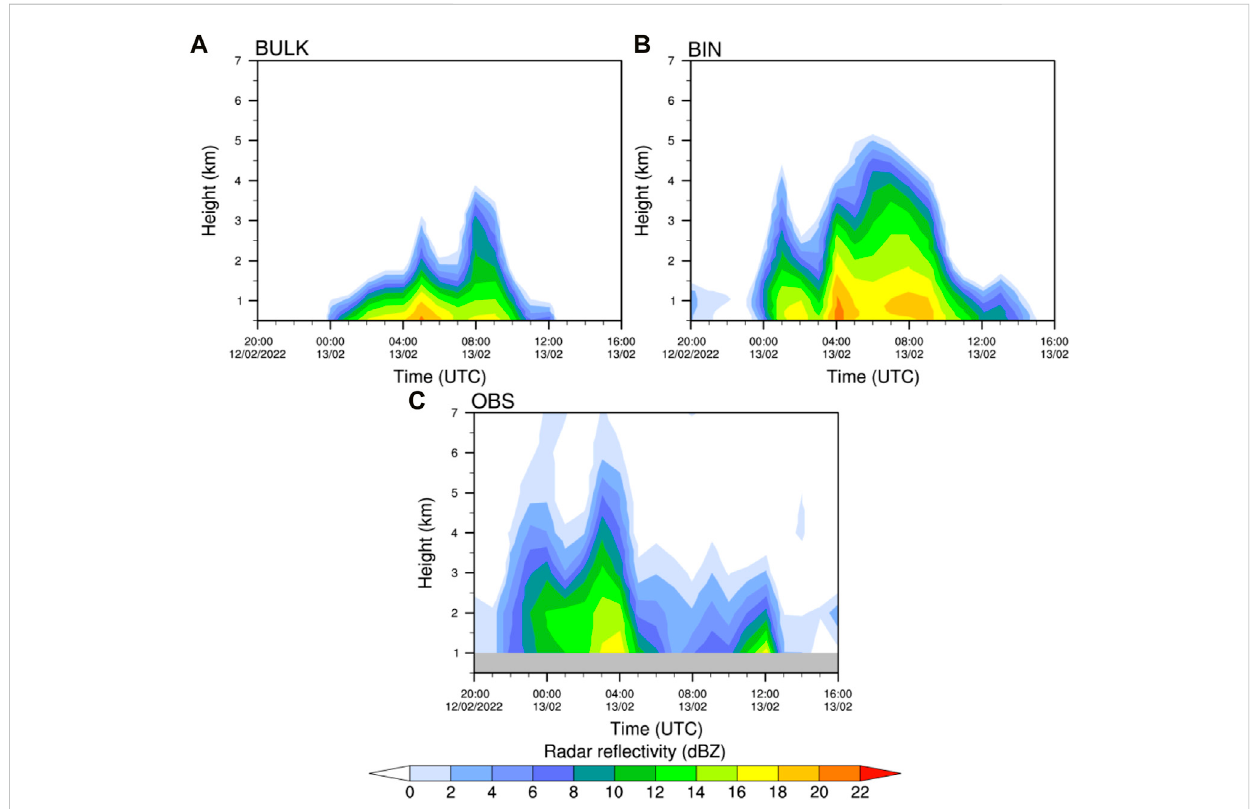
Time-height cross sections of regional average radar re fl ectivity for (A) the BULK scheme, (B) the BIN scheme, and (C) the observations from 2000UTConFebruary12to1600UTConFebruary13,2022(unit:dBZ).Regionsusedtocalculatetheregionalaverageareshownintheredrectanglesin Figures 4A3 – C3.